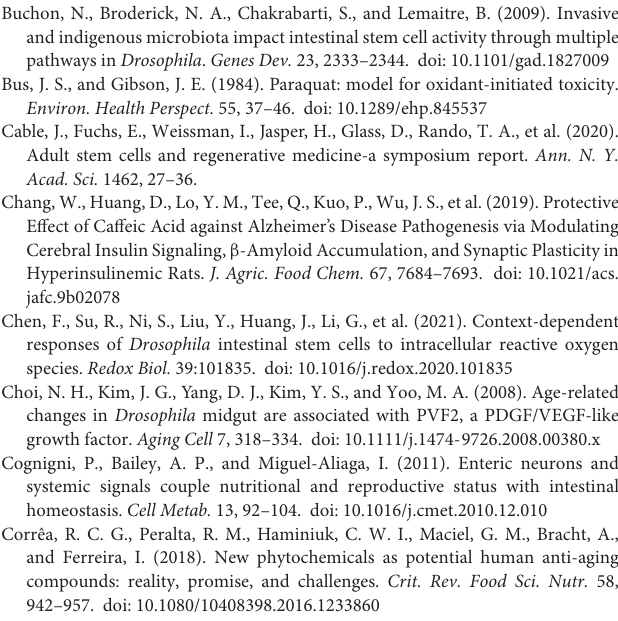
Supplementary Figure 3 | Caffeic acid prevents ISC aging by counteracting oxidative stress-associated JNK activity, related to Figure 6 . (A,B) Immunofluorescence images of the R4 region of dissected midguts of Drosophila carrying esg ts -GAL4- driven UAS-Bsk DN (A) , UAS-Bsk DN with CA supplementation